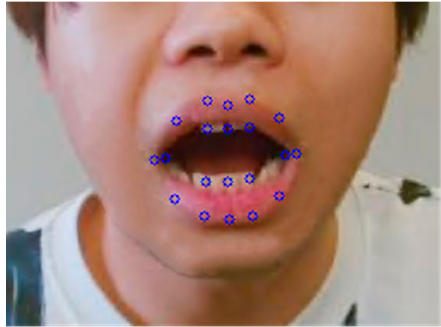
Figure 1. Example of lip area detection with a color camera.